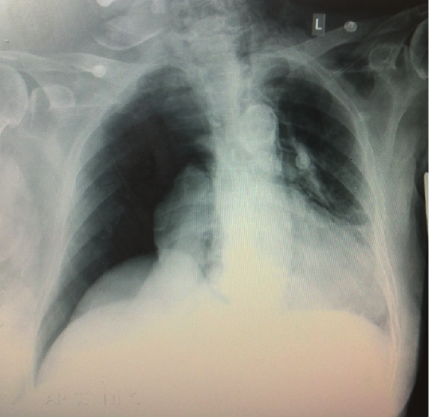
Figure 3: Chest X-ray showing right-sided pneumothorax. There is no intraperitoneal free